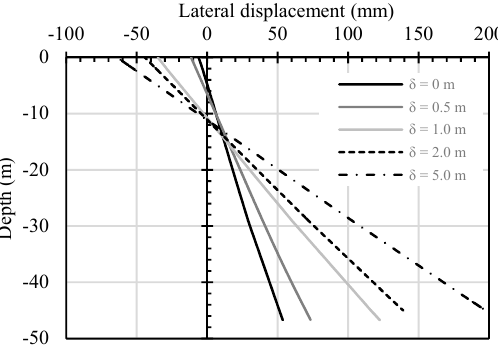
Figure 9. Variation curve of horizontal displacement along the caisson depth with different thick- nesses of the disturbance ring.